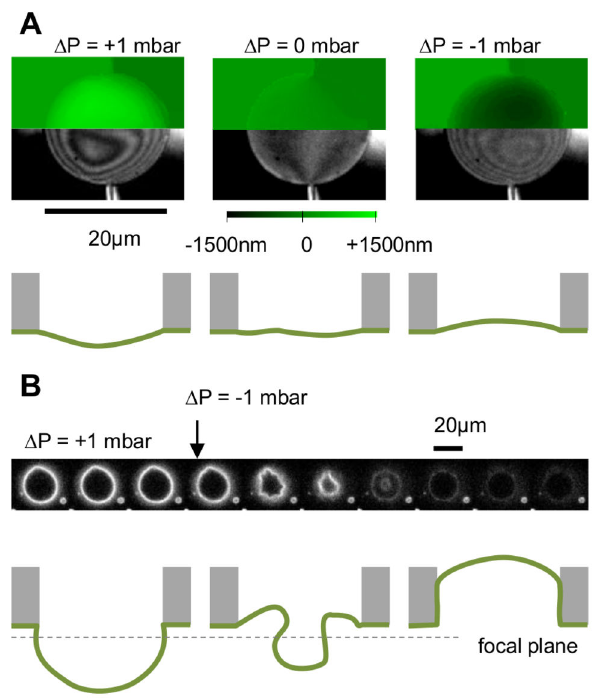
Figure 7. Pressure control and membrane deformation, under limited glass adhesion conditions. A\ RICM visualization of membrane deformation as response of applied pressure on membrane and corresponding sketch. B\ A large excess of membrane can sometimes be obtained. Large fluctuations can be observed at nearly equal pressure that lead to huge membrane fluctuations. DNA strand remains attached to the phage/FhuA complex (Figure 1C) for at least 2 h at least after the end of the ejection.